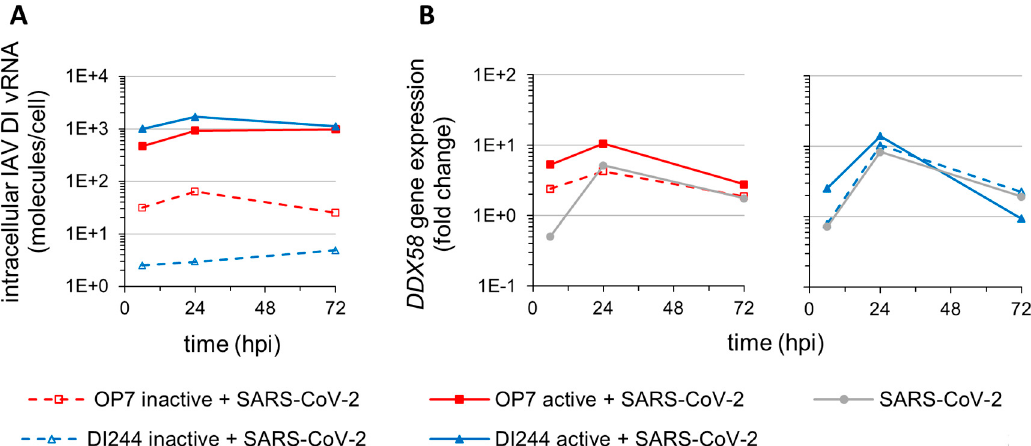
Figure 4. Cellular uptake of IAV DI vRNAs and DExD/H-box helicase 58 ( DDX58 ) expression. SARS-CoV-2-infected Calu-3 cells (MOI = 0.03) were treated with IAV DIPs (DI244 or OP7) at 1 hpi. For DI244 and OP7 infection, 10% ( v / v ) (100 µ L culture volume) of highly concentrated cell culture-derived DIP material was used [29,30]. At indicated times post-infection, cells were lysed to allow for total RNA extraction, required for ( A ) quantification of intracellular DI vRNAs and ( B ) analysis of DDX58 gene expression. Illustration includes data from one experiment. ( A ) Intracellular DI vRNA levels during SARS-CoV-2 and IAV DIP co-infection. Cells were assayed for viral RNAs by real-time RT-qPCR. ( B ) DDX58 gene expression analysis. DDX58 (encoding for RIG-I) transcript levels were quantified by real-time RT-qPCR and expressed as fold change (relative to untreated, uninfected cells).